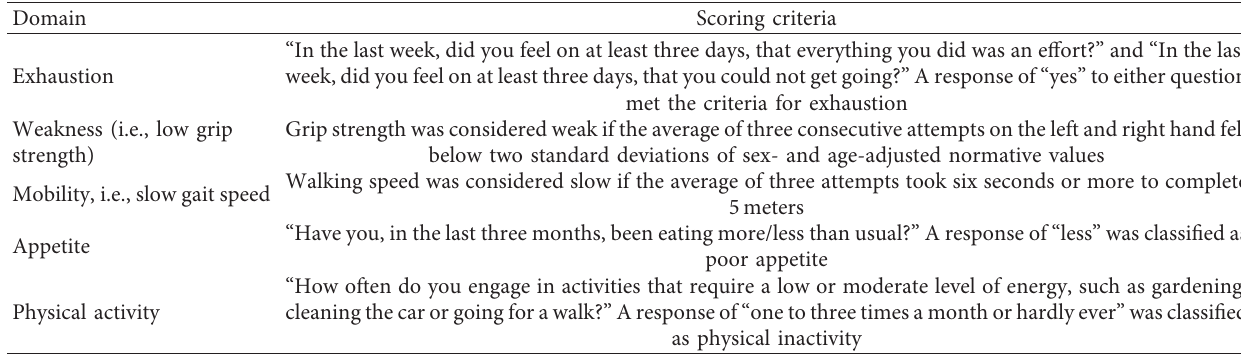
Table 1: Criteria for the modified Fried Frailty Phenotype (mFFP) binary score. A total of 5 physical domains were assigned 1 point if present or 0 if absent with FFP scores ≥ 3 considered frail and FFP � 0–2 considered nonfrail. Scoring